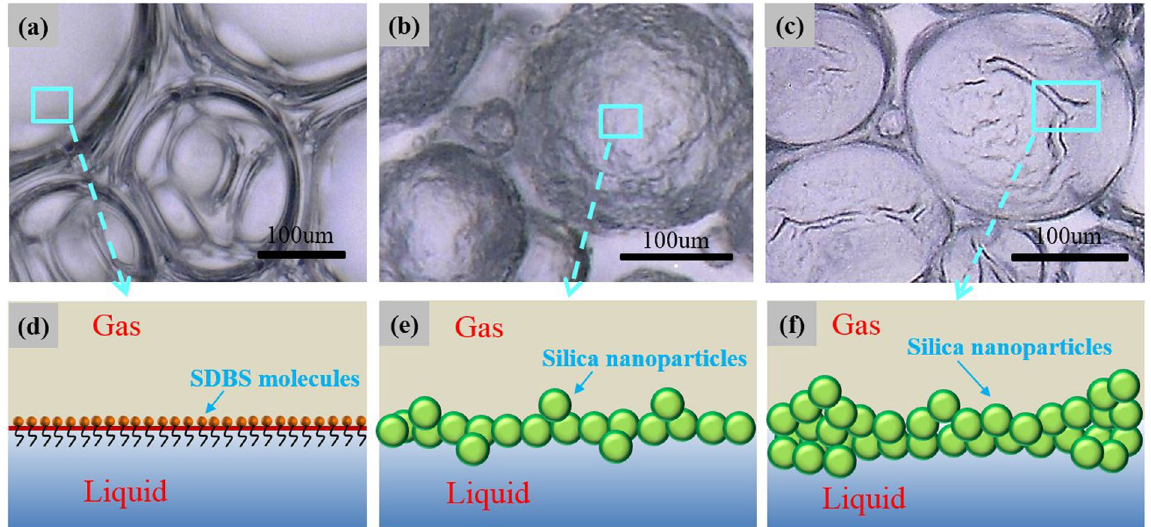
Figure 9. 3D microscopy images and the corresponding schematic illustrations of the microscopic structure of the bubble surfaces of ( a , d ) SDBS foam: 0.1 wt% SDBS + N 2 ; ( b , e ) SiO 2 /SDBS foam: 0.25 wt% SiO 2 nanoparticle + 0.1 wt% SDBS + N 2 ; ( c , f ) SiO 2 /SDBS foam: 1.00 wt% SiO 2 nanoparticle + 0.1 wt% SDBS + N 2